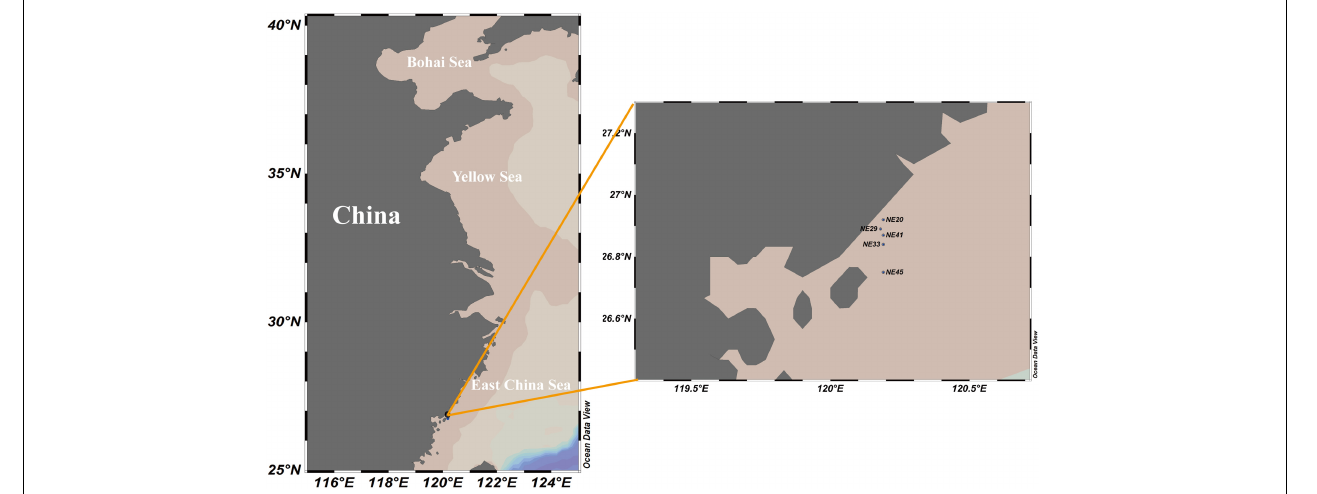
FIGURE 1 | Sediment sampling stations in Ningde coast,